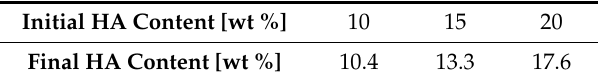
Table 3. Final contents of the HA phase in nanofibrous collagen/HA composite microspheres